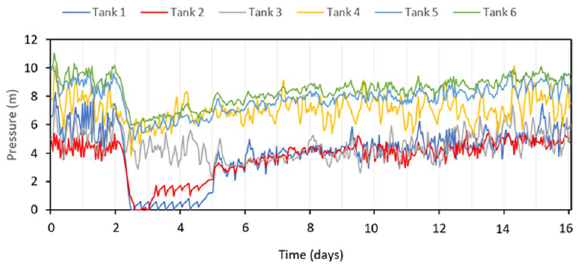
Figure 7. M-City WDN tank pressure under a 5.5 M earthquake at Location 1, and repair strategy, RS2.